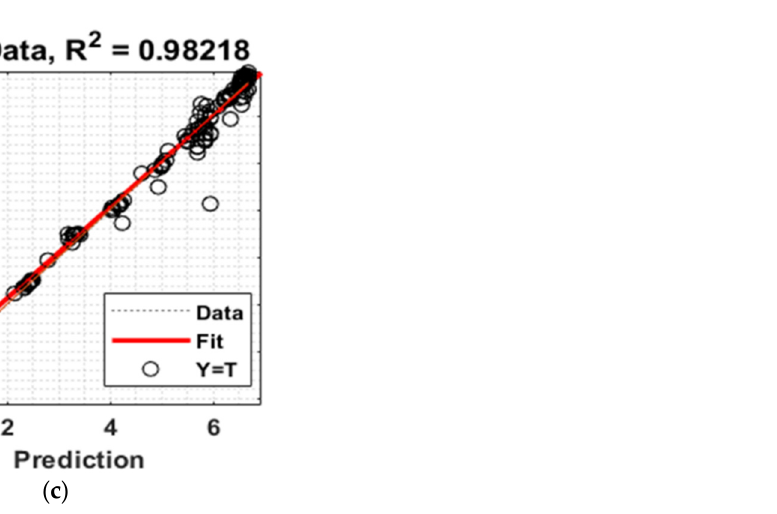
Figure 8. ( a )The observed and predicted results,( b ) error metrics and ( c )regression plot considering Figure 8. ( a ) The observed and predicted results, ( b ) error metrics and ( c ) regression plot considering solar irradiance-Sweihan photovoltaic independent power project, Abu Dhabi-for Multistep CNN- stacked LSTM stacked LSTM.